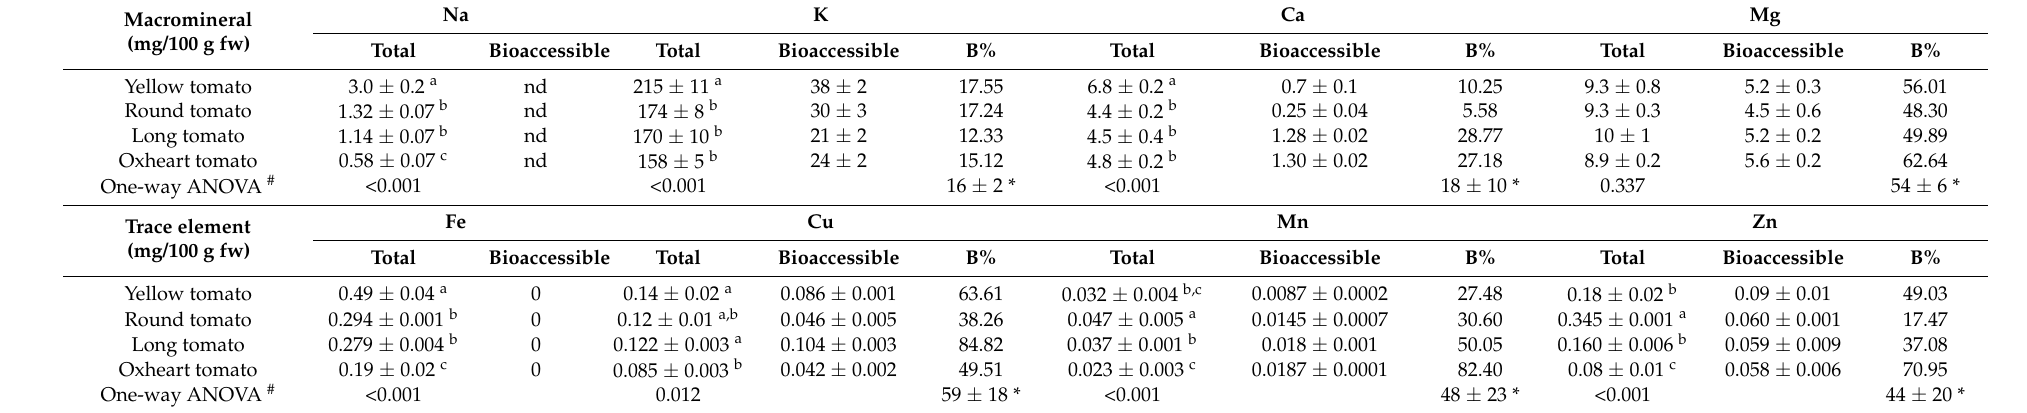
Table 2. Total and in vitro bioaccessible macrominerals and trace elements of four tomato farmers’